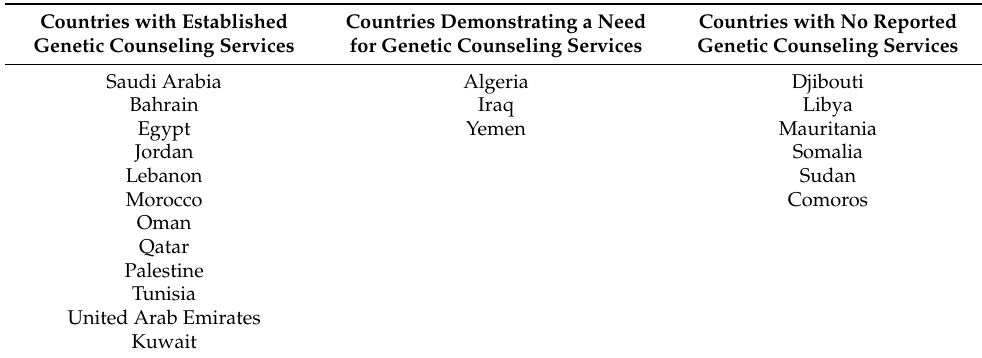
Table 1. The implementation status of genetic counseling services across the 22 Arab countries based on the available